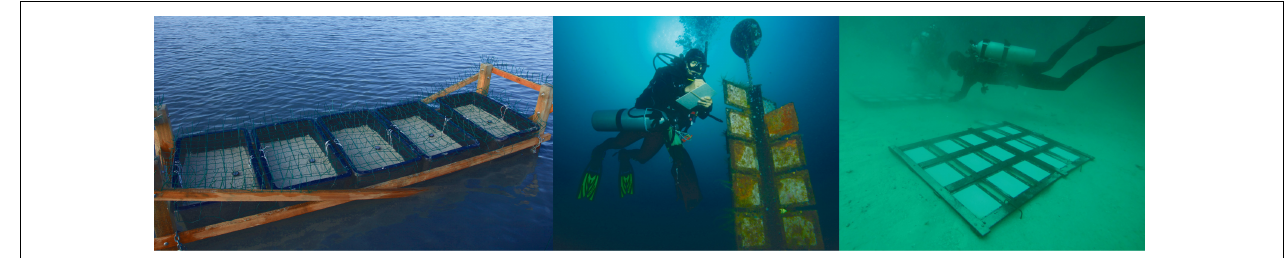
FIGURE 1 | Field test systems: left: eulittoral test: Samples were exposed in bins filled with beach sand on a rack in the midwater line, center: pelagic tests: samples attached to a floating rack exposed at 20 m water depth, right: benthic tests: samples were mounted in panels that were fixed on the sandy seafloor at 40 m (Mediterranean Sea) and 32 m water depth (SE Asia).